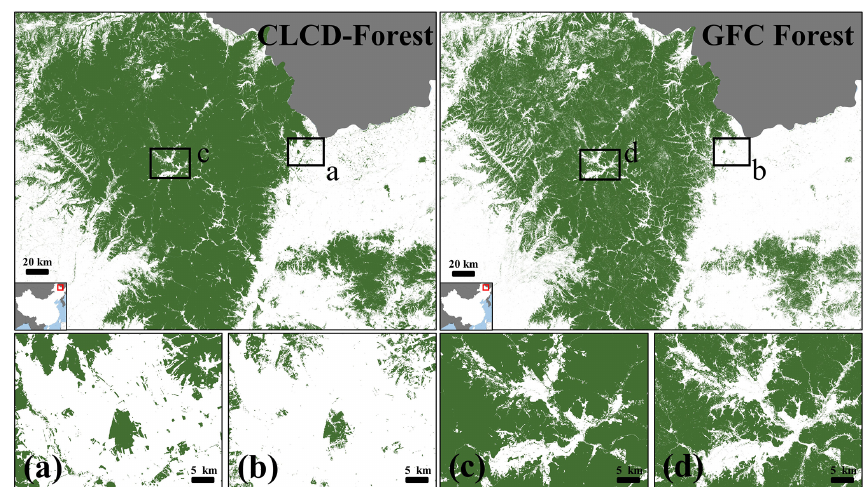
Figure 9. Example of 2019 forest maps for CLCD and GFC located at the Lesser Khingan Mountains (47.703792 ◦ N, 129.388820 ◦ E).